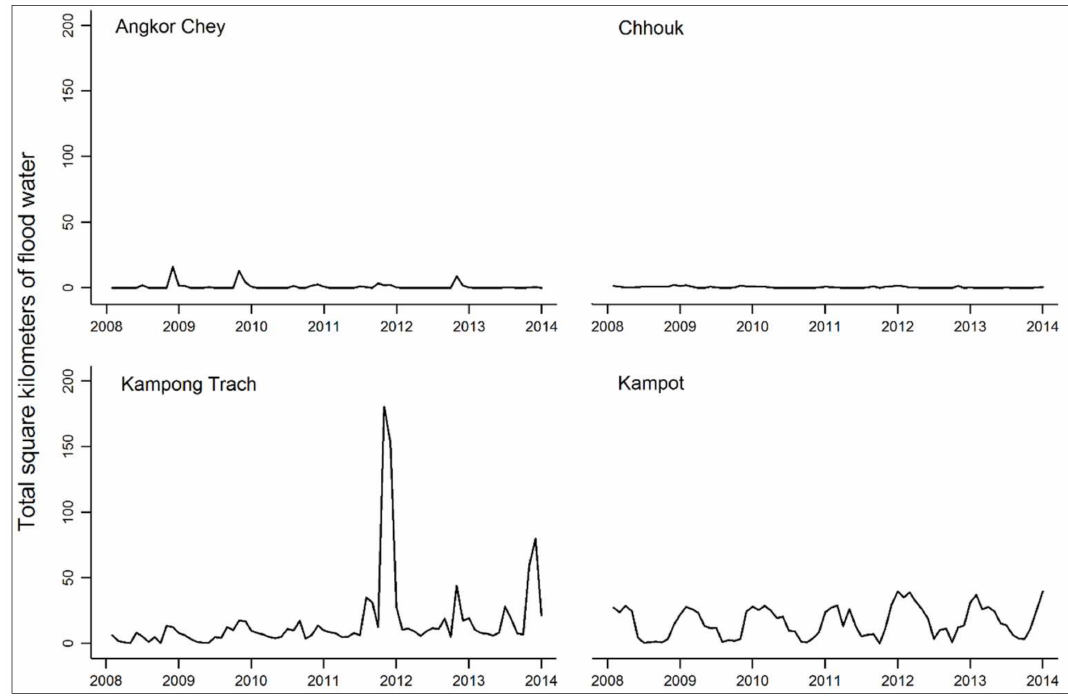
Figure 3. Total number of square kilometers flooded in the districts of Kampot province between January 2008 and December 2013.